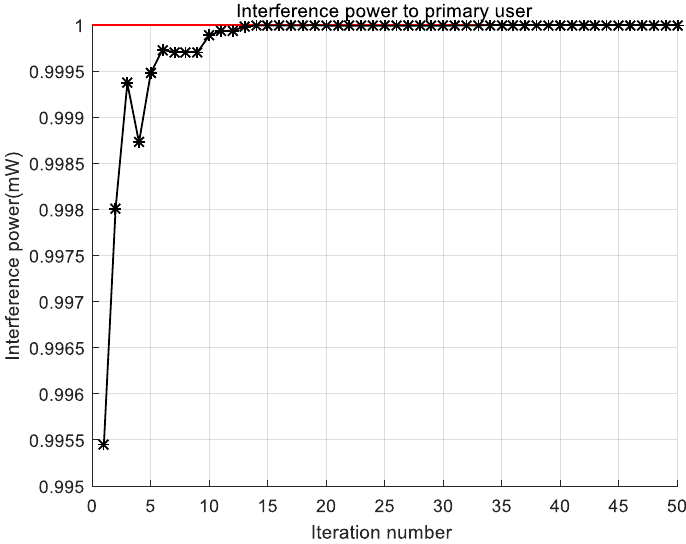
Figure 7. Cognitive user interference power to primary user.